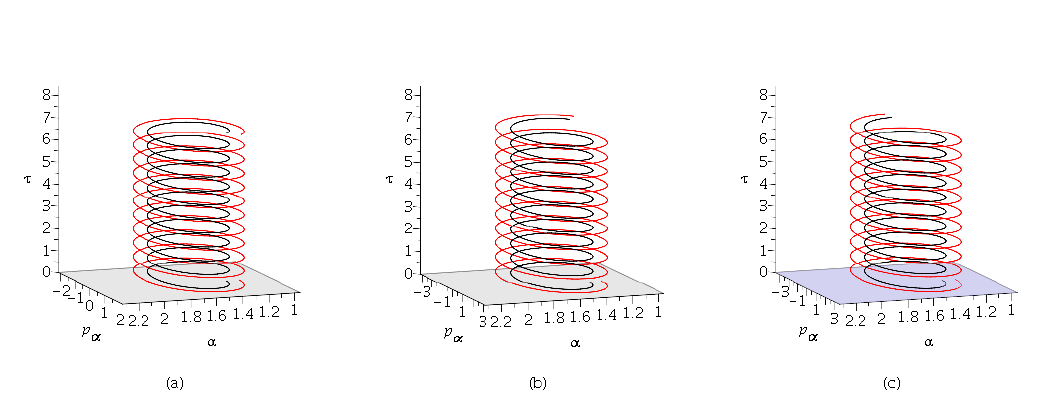
Figure 6 . Phase space trajectories with nearby initial conditions for the C P 2 ansatz, here plotted for m = 1 ; (cid:20) = 5, and varying values of the deformation parameter q . (a) q = 1, (b) q = 3 = 2 and (c) q = 5 = 3. The total energy is restricted to H = 0 due to the Virasoro